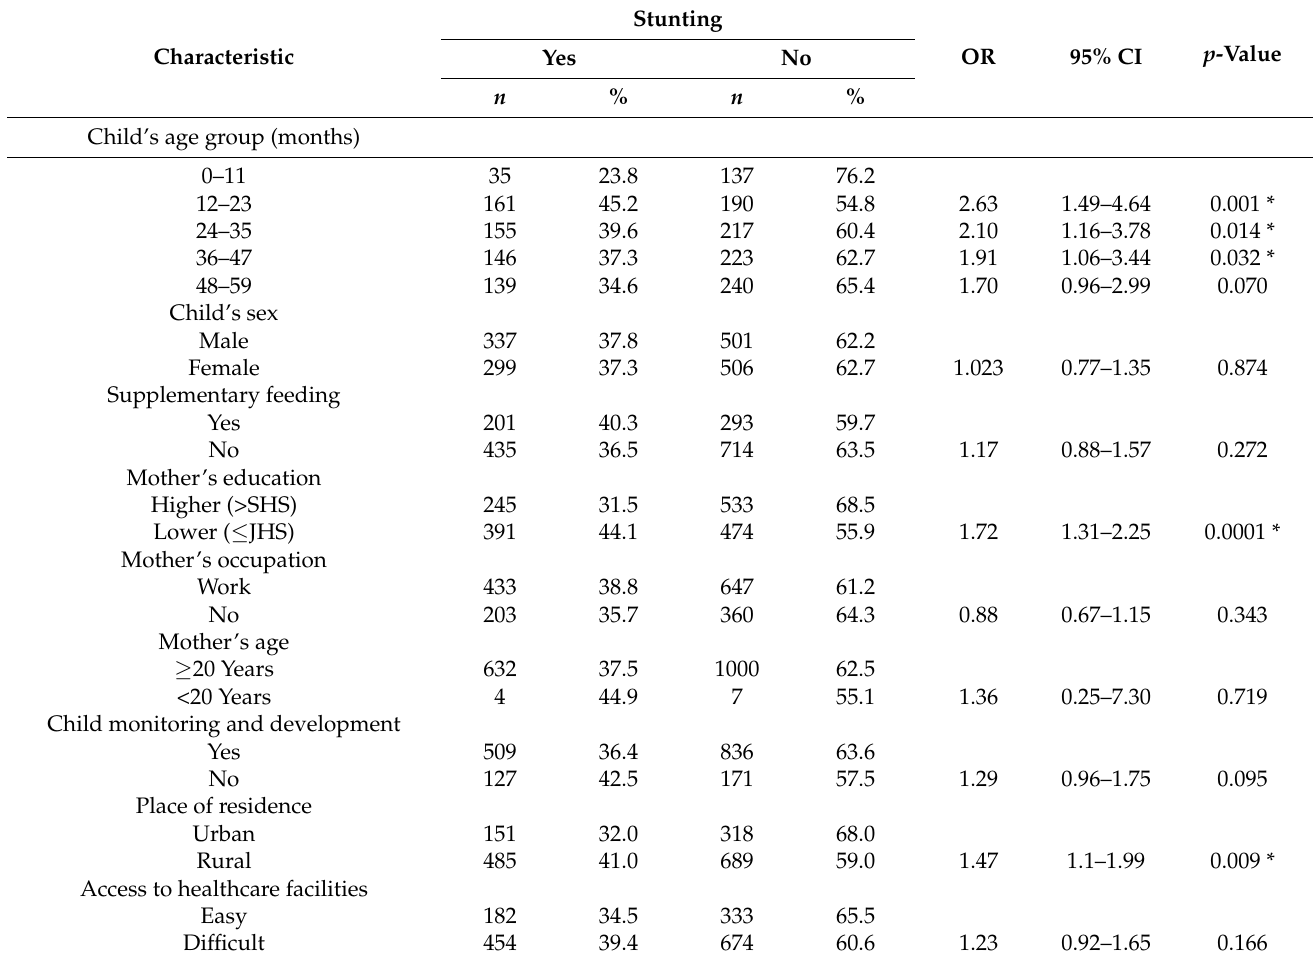
Table 2. Relationship between stunting and characteristics of respondents.